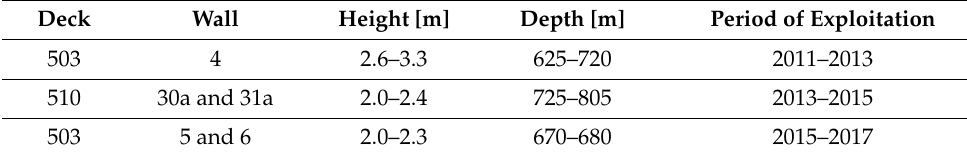
Table 1. Characteristic parameters of mining operations in the analysed area.